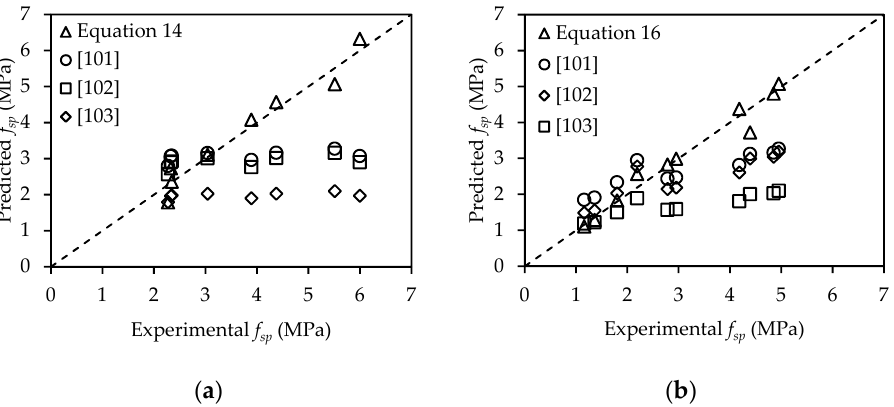
Figure 17. Predicted versus experimental splitting tensile strength for mixtures with slag:fly ash of: ( a ) 3:1; ( b ) 1:1.